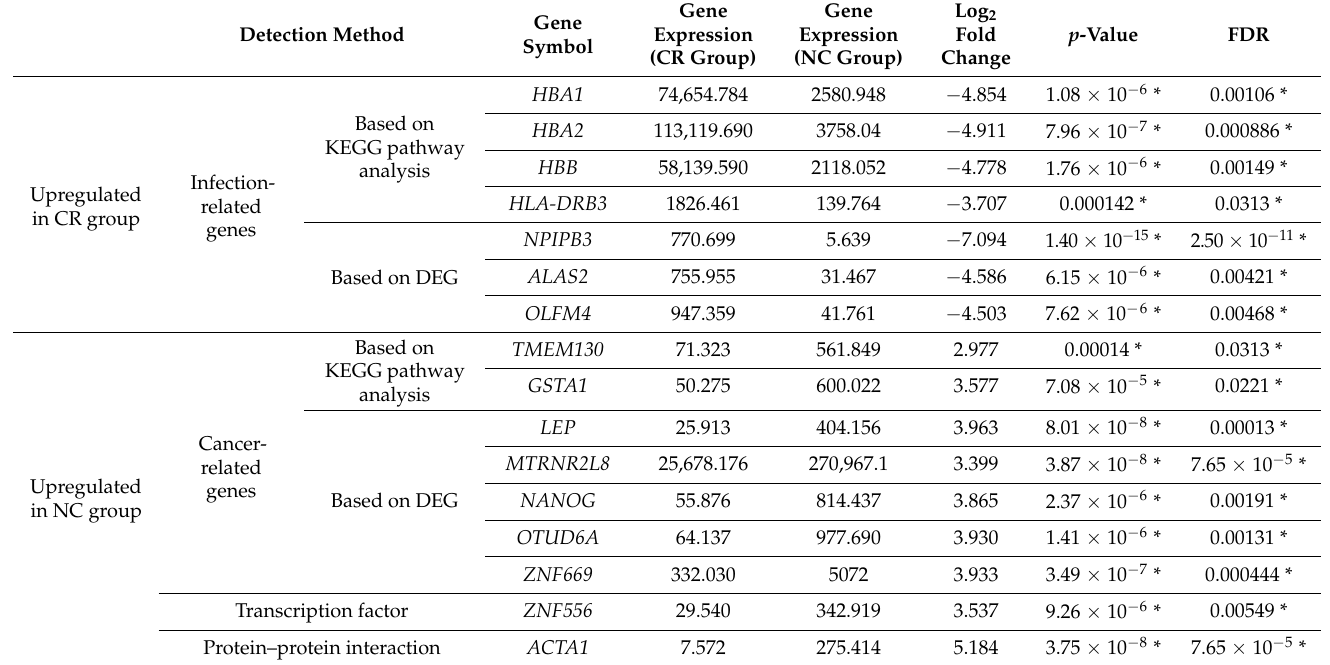
Table 2. Detected candidate genes.